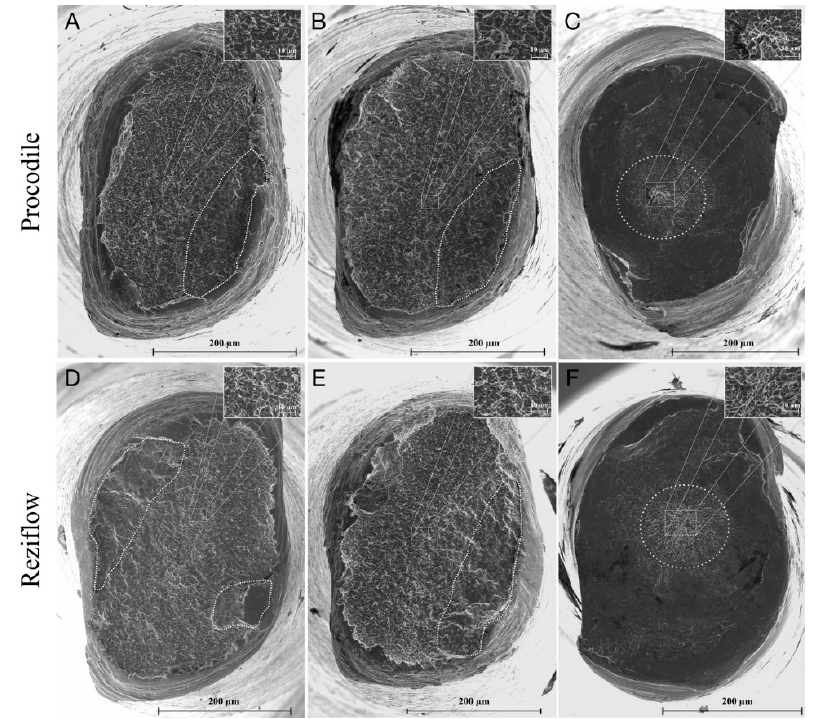
Figure 1. Field-emission gun scanning electron microscopy (FEG-SEM) micrographs of fracture surface (axial view) of Procodile ( A – C ) and Reziflow ( D – F ) after the cyclic fatigue test at 20 ◦ C ( A , D ) and at 37 ◦ C ( B , E ) and after torsional test ( C , F ). Dotted lines ( A , B , D , E ) highlight the crack propagation area, and insets show magnified details of dimples in the overload fracture area. The dotted circles ( C , F ) indicate concentric abrasion marks, and insets show magnified details of skewed dimples near the center of the section. Table 2. Cross-section area ( µ m 2 ) of Procodile and Reziflow at di ff erent levels from the tip to the shaft.